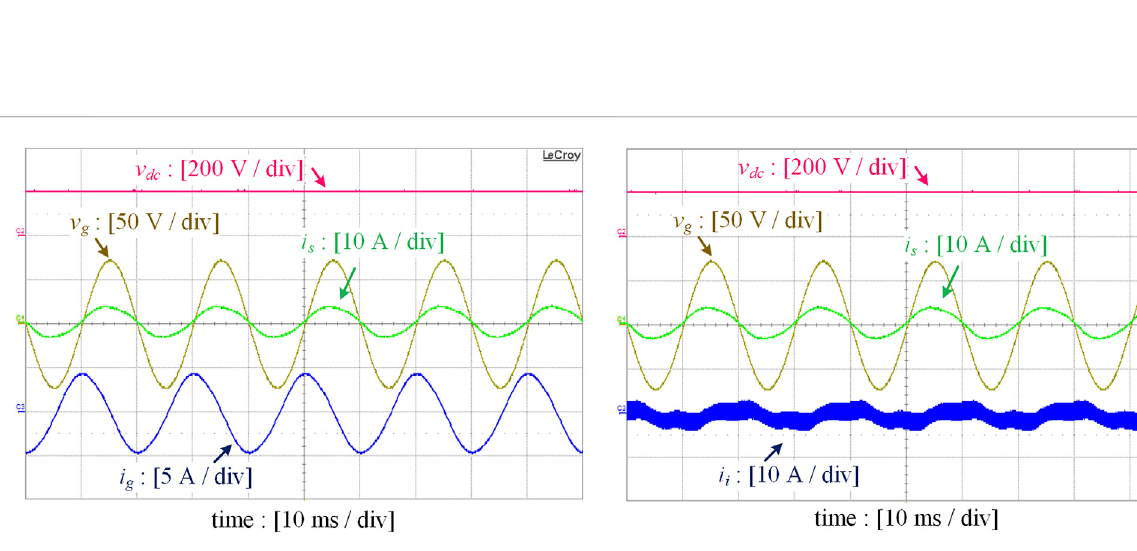
FIGURE 10 Experimental waveforms with reactive power compensated by the proposed DSTATCOM under light load